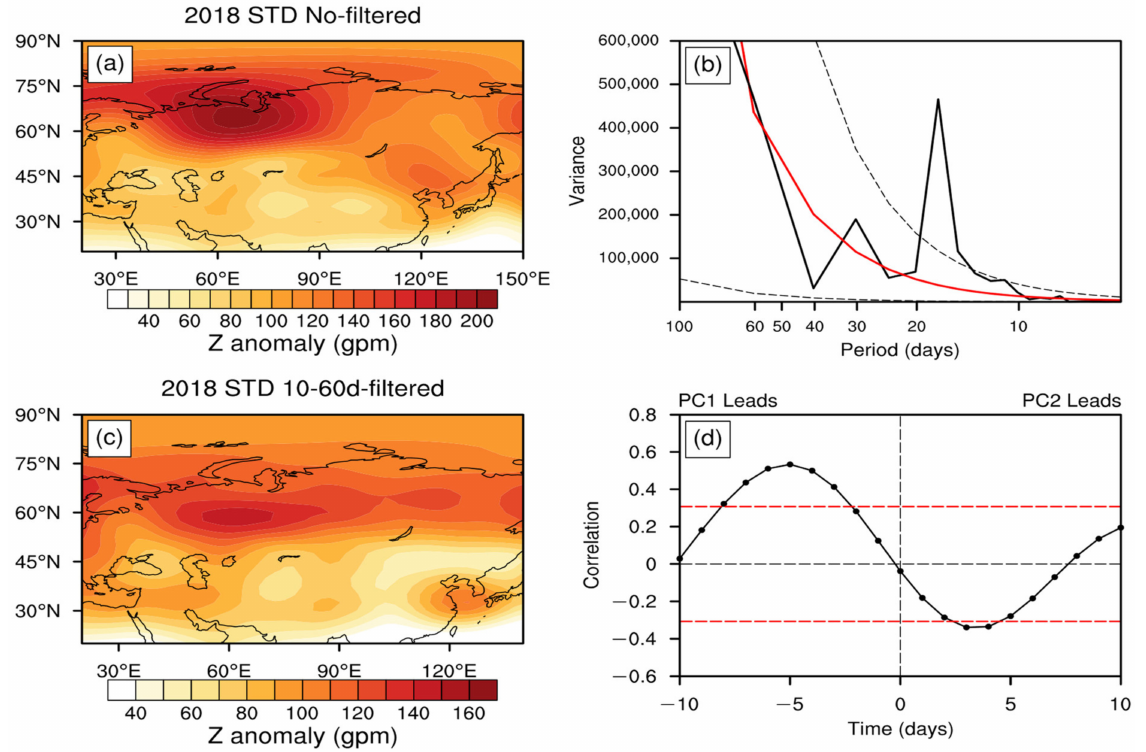
Figure 4. ( a ) Standard deviation (STD) of non-filtered geopotential height anomalies (unit: K; removing the mean and first four harmonics of the annual cycle, then conducting a 5-day running mean) at 250 hPa during 2018 wintertime (from 2017 December to 2018 March, DJFM). ( b ) Power spectral (black solid line) analysis of non-filtered geopotential height anomalies at 250 hPa averaged from 50 ◦ to 70 ◦ N, from 40 ◦ to 80 ◦ E in 2018 wintertime. The red solid line denotes the red noise spectrum, and dashed curves represent its 0.05 and 0.95 significant levels. ( c ) As in ( a ), but for 10–60-day filtered geopotential height anomalies. ( d ) The lead–lag correlation of PC1 and PC2 in 2018 wintertime (black solid line). The negative (positive) days indicate that PC1 leads (lags) PC2; the red dotted lines represent the 0.05 confidence level, and the black dashed lines are zero-contour